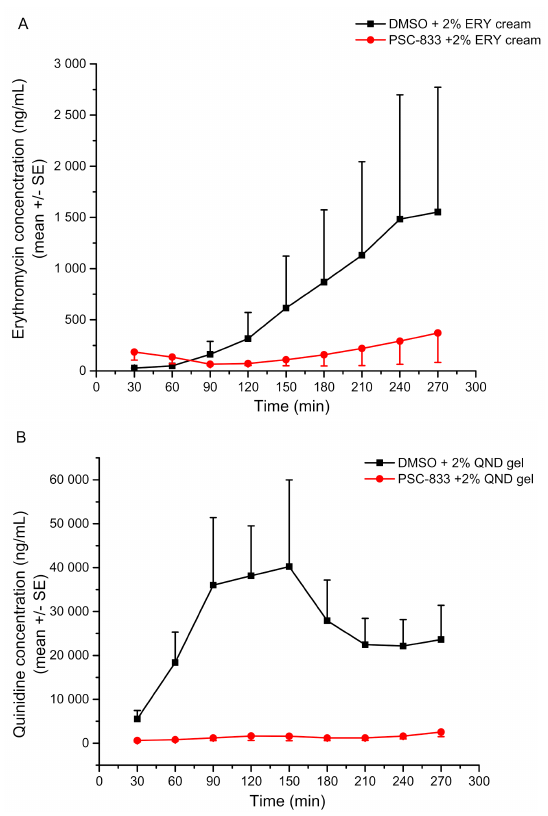
Figure 5. Skin penetration of erythromycin cream (ERY) and quinidine gel (QND) (Panel ( A , B ), re- spectively) across the freshly prepared excised young rat abdominal skin in the microfluidic chip. Concentration data are shown as means +/ − SE, n = 3–5 [30]. The P-gp inhibitor (PSC-833) significantly reduced QND and ERY penetration through the